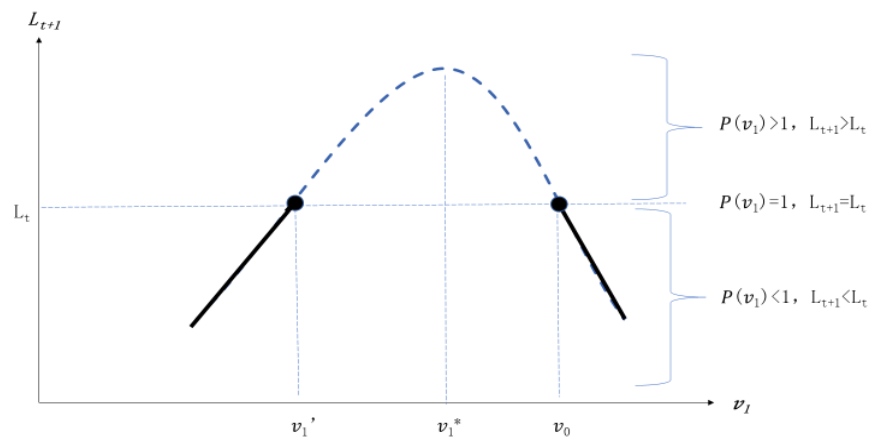
Figure 1. The initial investment of infrastructure is higher. Note: v is the proportion of public ex- penditure on transportation and L is the number of labors in second sector.